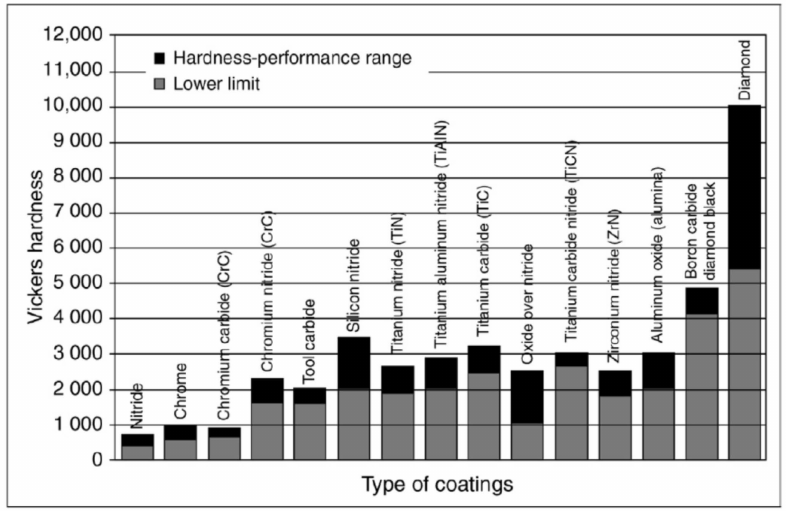
Figure 18. The hardness of different coating materials with a lower limit and suitable performance range [125].